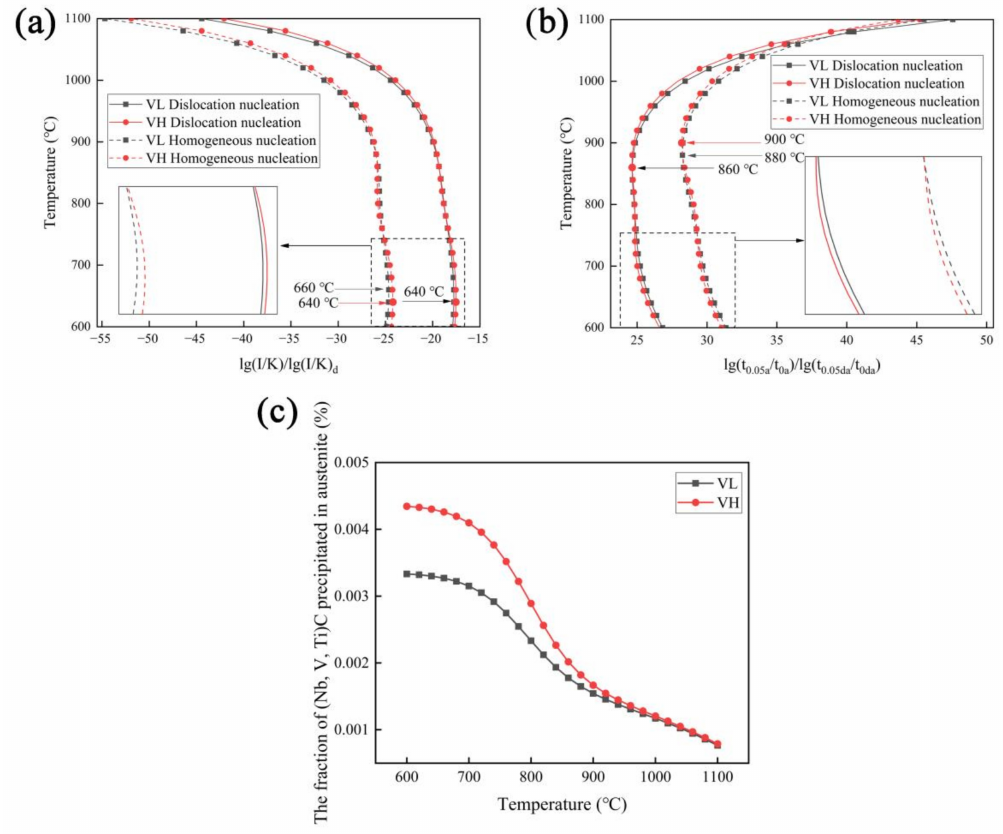
Figure 11. ( a ) The NrT curve (nucleation rate–temperature curve); ( b ) the PTT curve (precipitation– time-temperature curve); ( c ) the curves of the fraction of (Nb, V, Ti) C precipitated in austenite versus